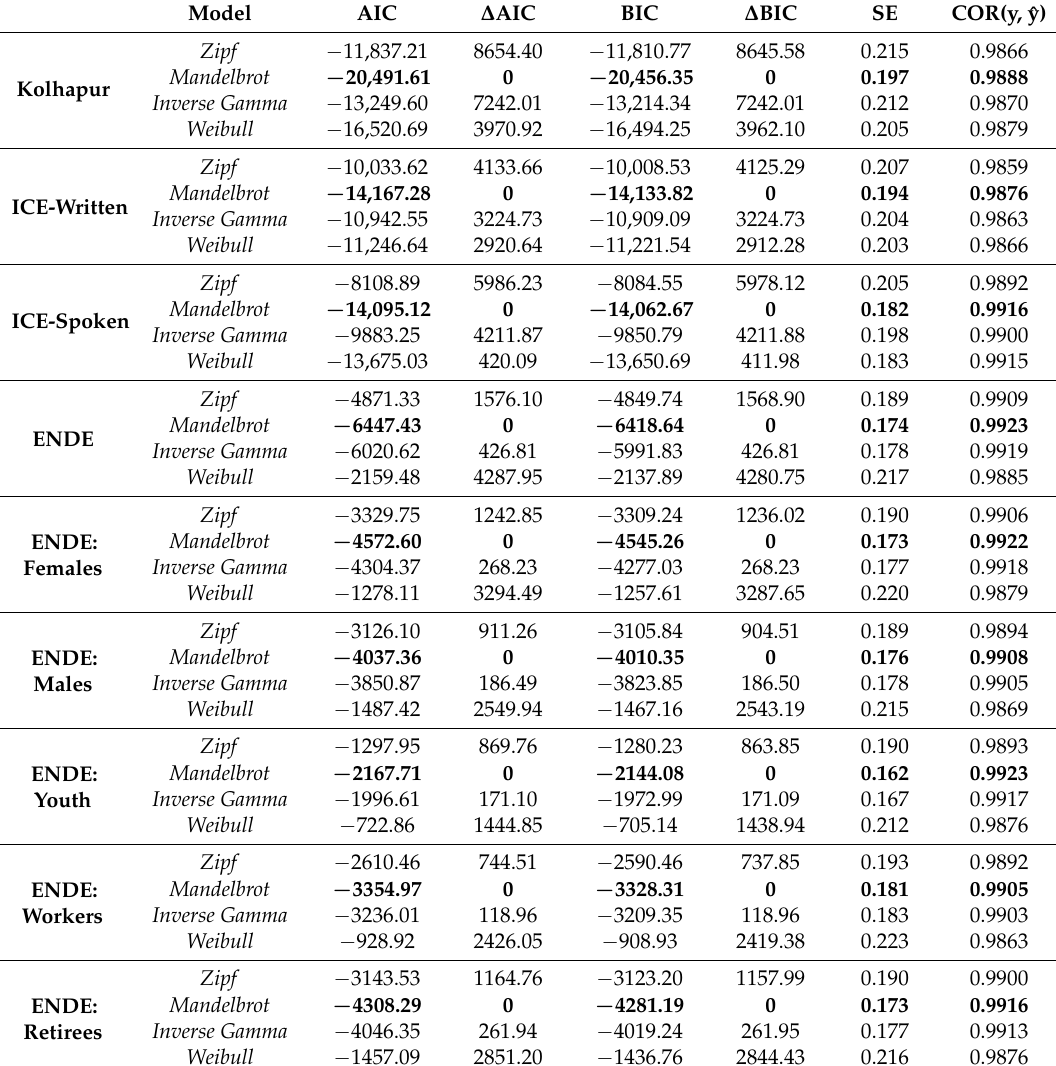
Table 3. Comparing model fits by corpus.